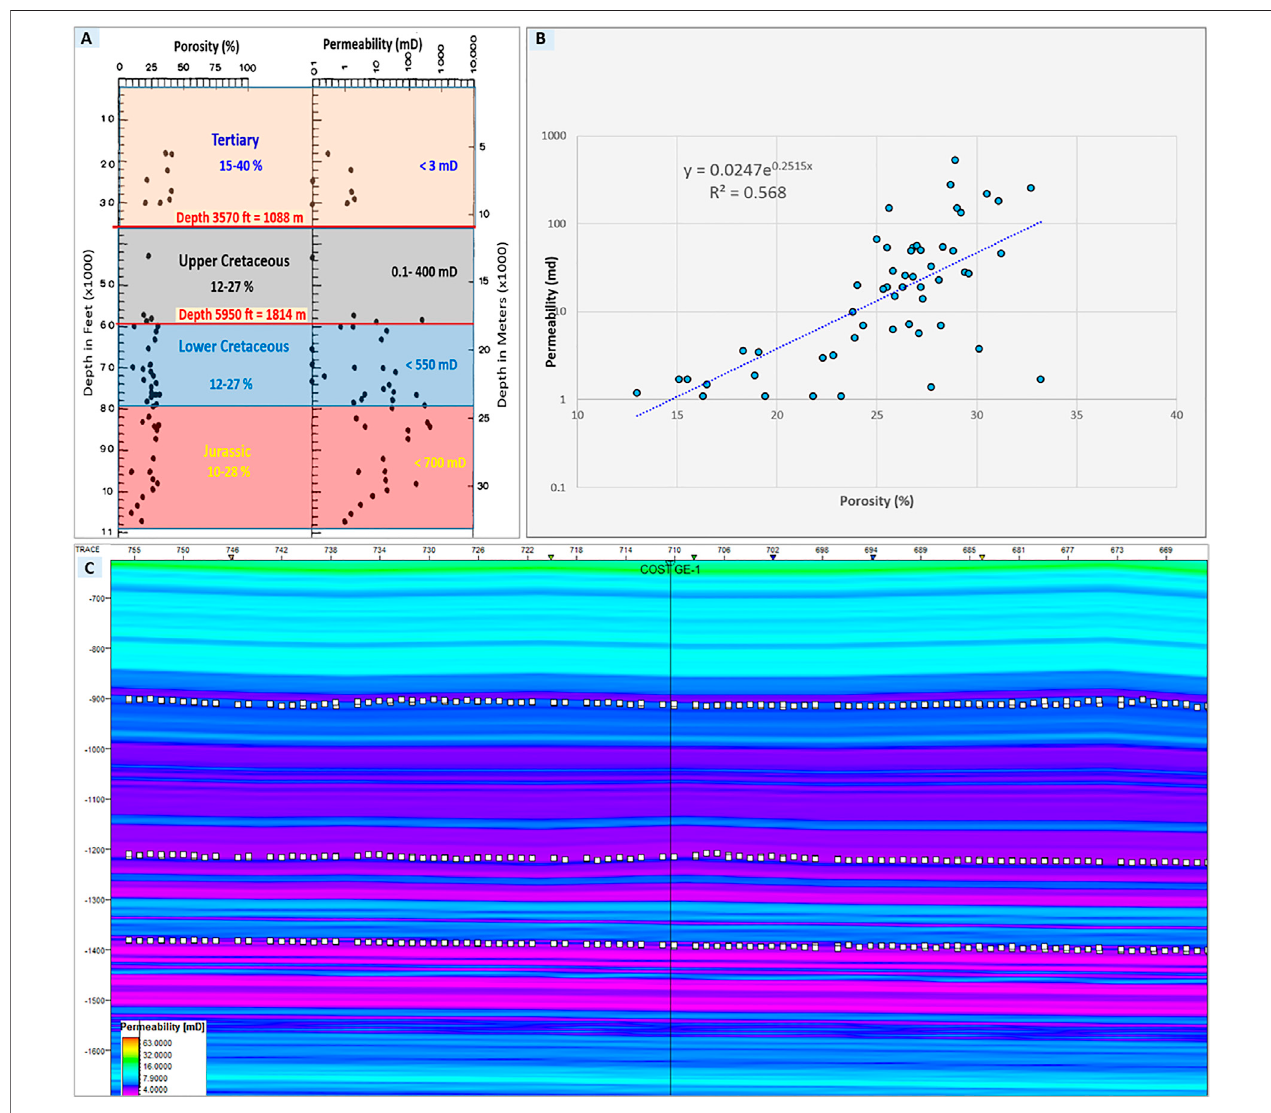
FIGURE13 | Porosity and permeability relationship at the COST GE-1 well: (A) valuesmeasured on conventional and sidewall cores asa function ofdepth (Amato and Bebout, 1978; Almutairi et al., 2017); (B) cross plotting core porosities versus core permeabilities for the entire well, data from Scholle (1979). (C) Permeability distribution using the core ’ s porosities and permeability